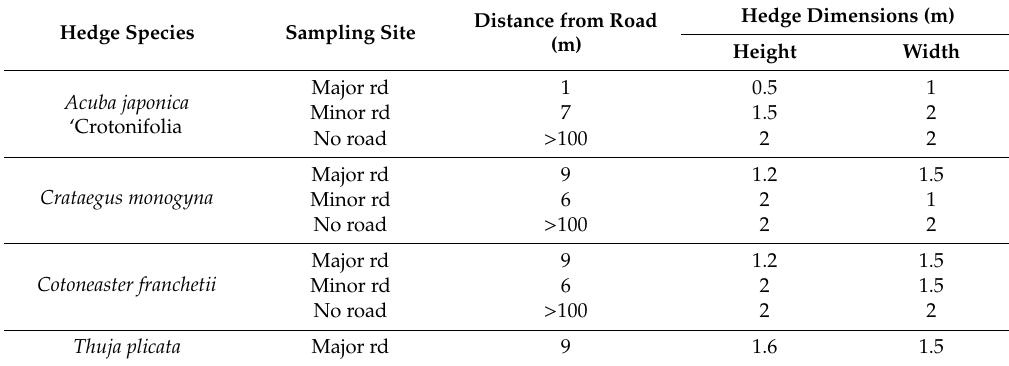
Table 3. Hedge species sampled in Experiment 3, along with the associated detail of sampling locations.